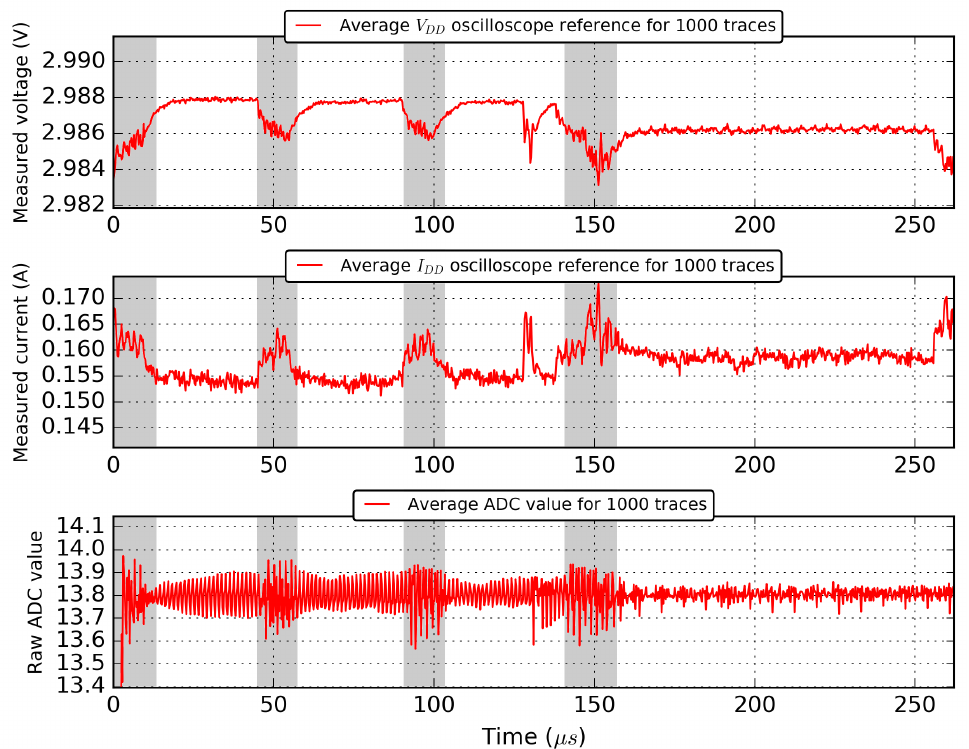
Figure 5: Average over 1000 traces for oscilloscope measurements on V dd and I dd in the first two plots and average of concurrently measured ADC values when the ADC was set to 6-bit and the pin was not connected (N/C) on the bottom. High activity phases are marked